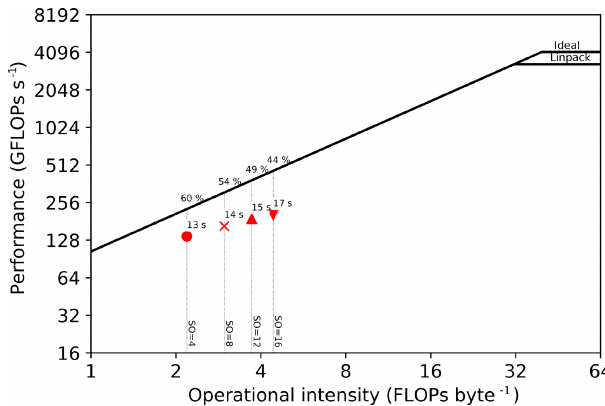
Figure 22. Roofline plots for a 512 × 512 × 512 model on a Skylake 8180 architecture. The runtimes correspond to 1000ms of modeling for four different spatial discretization orders (4, 8, 12,